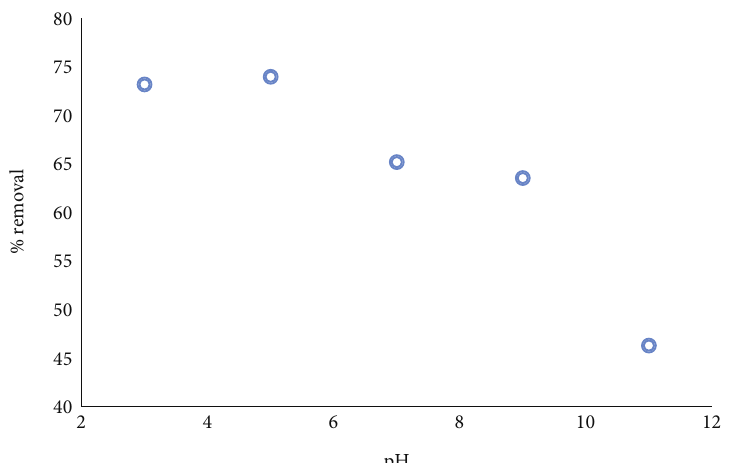
= 50mg : L − 1 , pH = 3 − 11 , sonication time = 60 min , and i